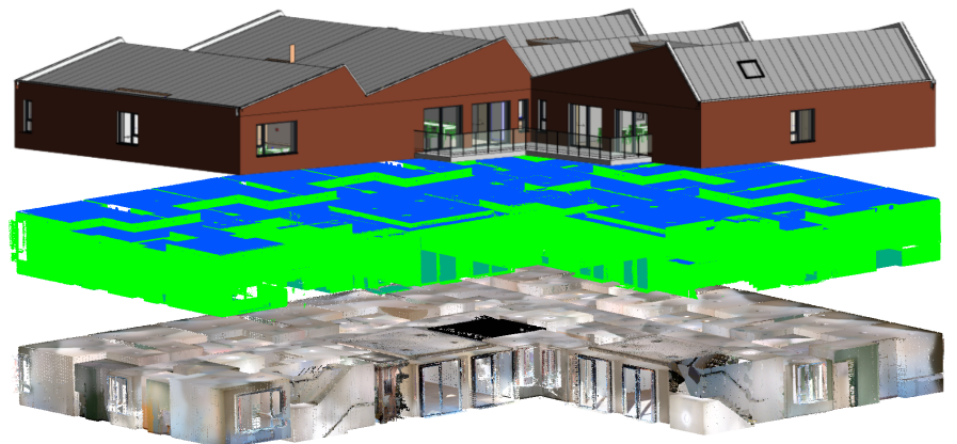
Figure 1. Overview of the vital semantic segmentation step that interprets the raw point cloud data and makes it fit for BIM